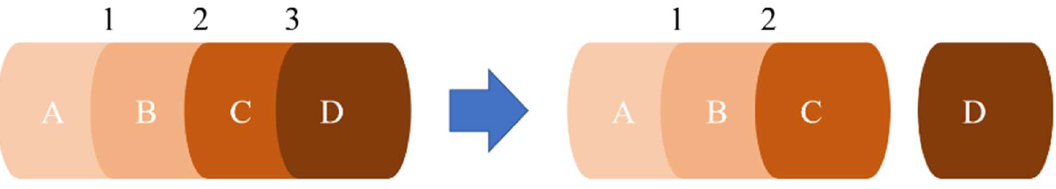
Figure 5. Separation number of four